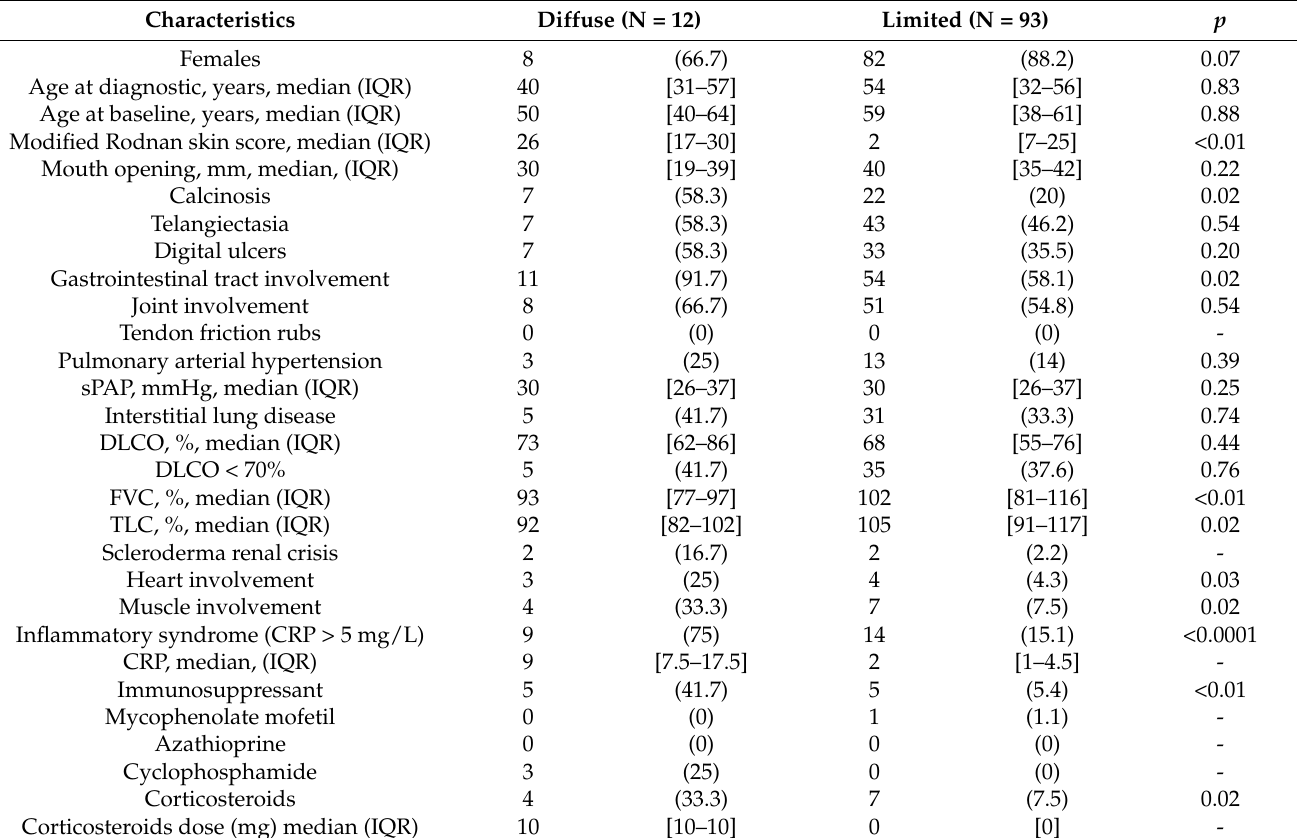
Table 1. Characteristics of patients with anti-centromere antibodies (ACA).